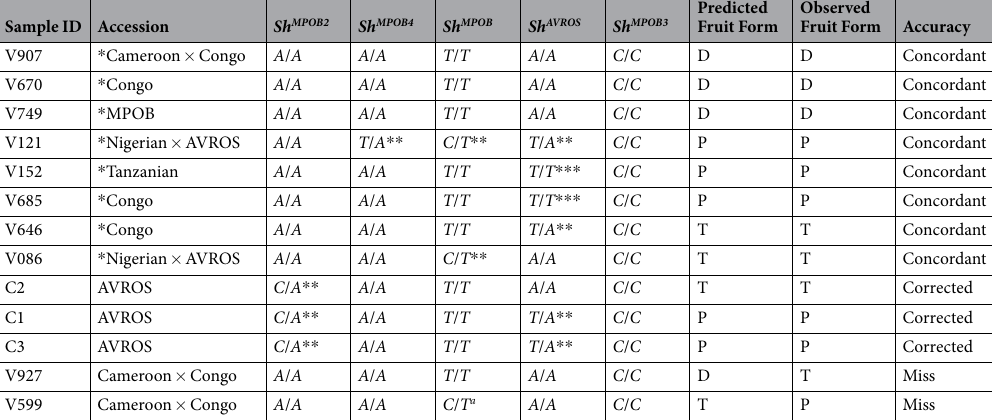
Table 3. The prediction accuracy of fruit form based on haploinsufficiency model and genotypes of five discrepancies and eight controls tested in the second validation set. * Control samples tested using M1 and M2 in the second validation set. D – dura ; T – tenera ; P – pisifera . Highlighted genotype indicated the presence of mutation ( ** heterozygous; ***